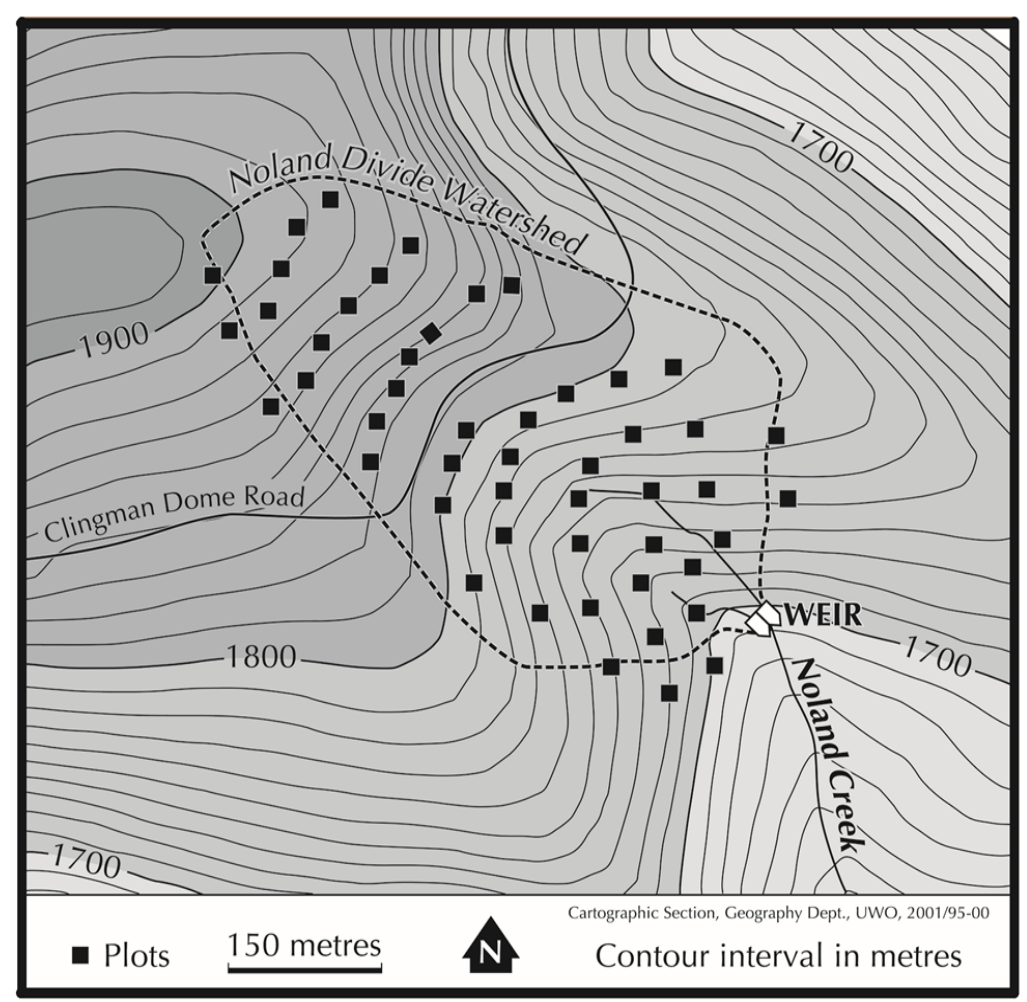
Figure 1. Map of the Noland Divide Watershed and the systematic network of 50 permanent